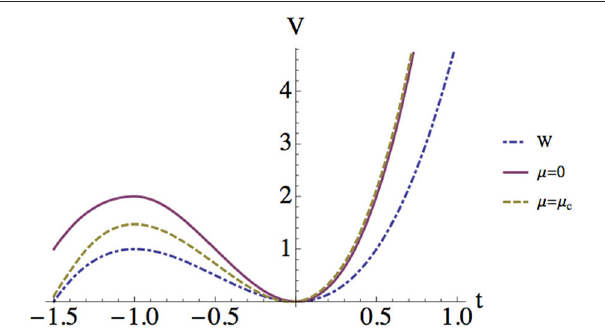
FIGURE 4 | Effective potential at large N . The value of the potential is normalized by 1 / (6 µ ). The original potential W ( t ) is shown together.